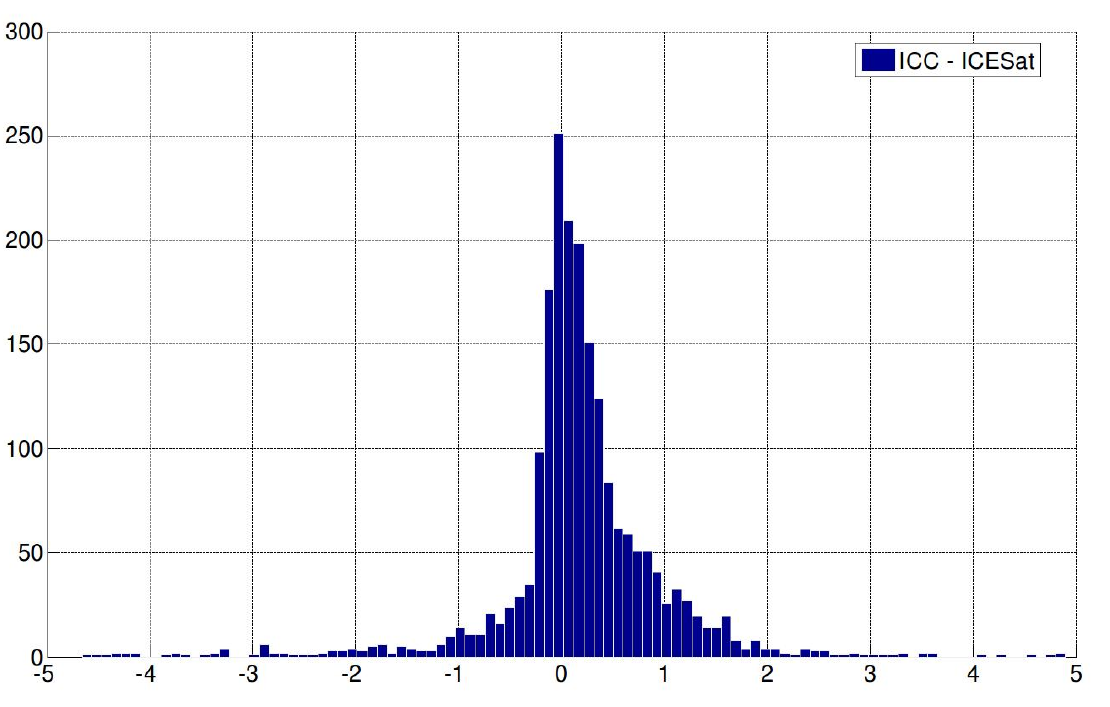
Figure 17. Difference between the ICESat points and ground truth ICC